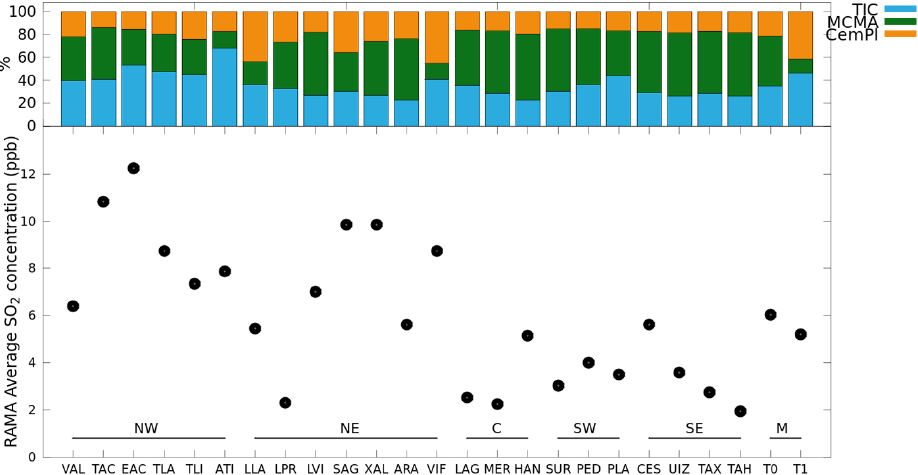
Figure 6. Contribution of TIC (blue), urban sources (green) and cement plants (orange) to SO 2 levels in the MCMA. Filled circles denote the average concentration at each station over the entire simulation period. Stations are arranged by region within the MCMA. “M” denotes MILAGRO supersites.